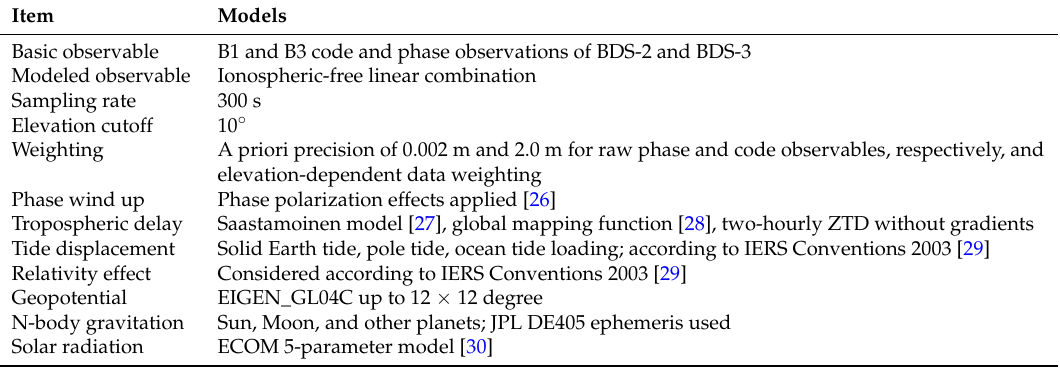
Table 3. Important options of the GNSS processing for